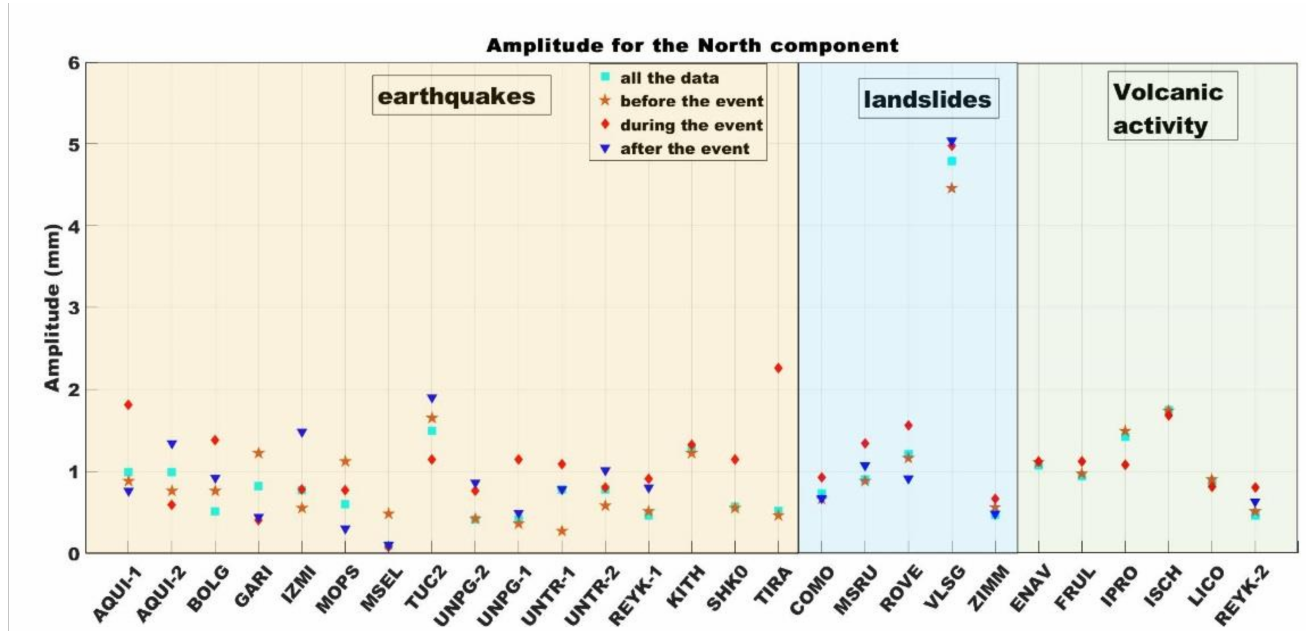
Figure 5. Seasonal signal values for the North component in the presence of a geophysical event using the four above- mentioned computational